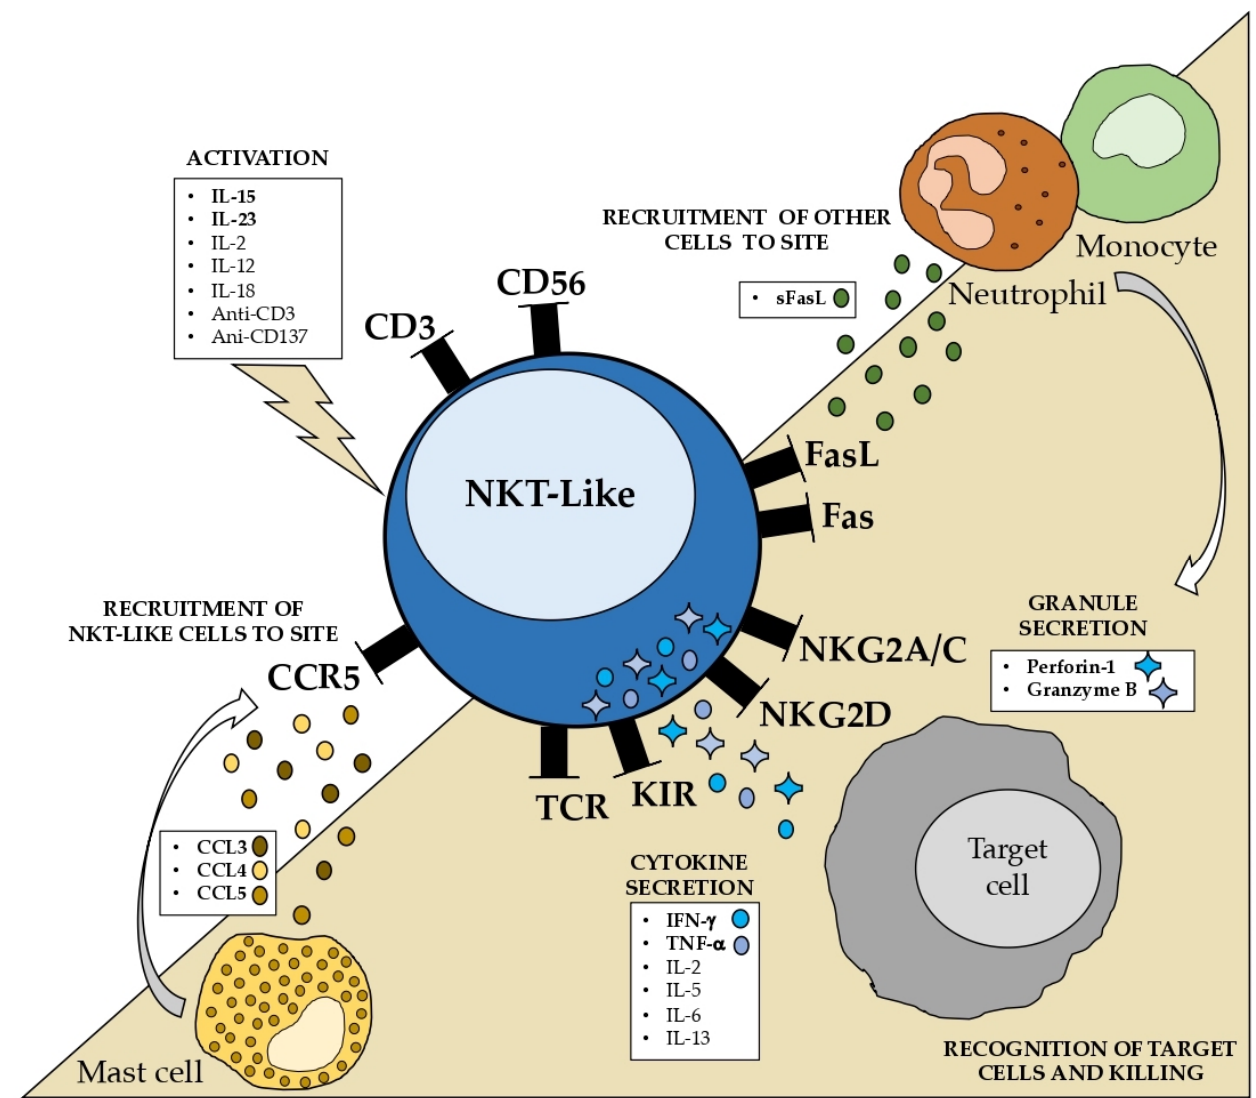
Figure 3. Illustration of the properties of NKT-like cells. NKT-like cells become activated when exposed to IL-15 and IL-23, but less so when exposed to IL-2, IL-12, IL-18, anti-CD3, and anti-CD137. IFN- γ and TNF- α are strongly produced in response to the majority of these molecules, and NKT-like cells also secrete IL-2, IL-5, IL-6, and IL-13. Mast cells secrete cytokines (CCL3, CCL4, and CCL5) attract NKT-like cells to the injured site. On the other hand, the production of soluble FasL may trigger the recruitment of additional immune cells such as neutrophils and monocytes. The effector function of NKT-like cells is regulated by the recognition of target cells through the TCR, KIR, NKG2A/C, and NKG2D receptors. When activated, NKT-like cells also release granules, such as perforin-1 and granzyme B, which are the path of choice to kill target cells. TCR—T cell receptor; KIR—killer-cell immunoglobulin-like receptor; sFasL—soluble